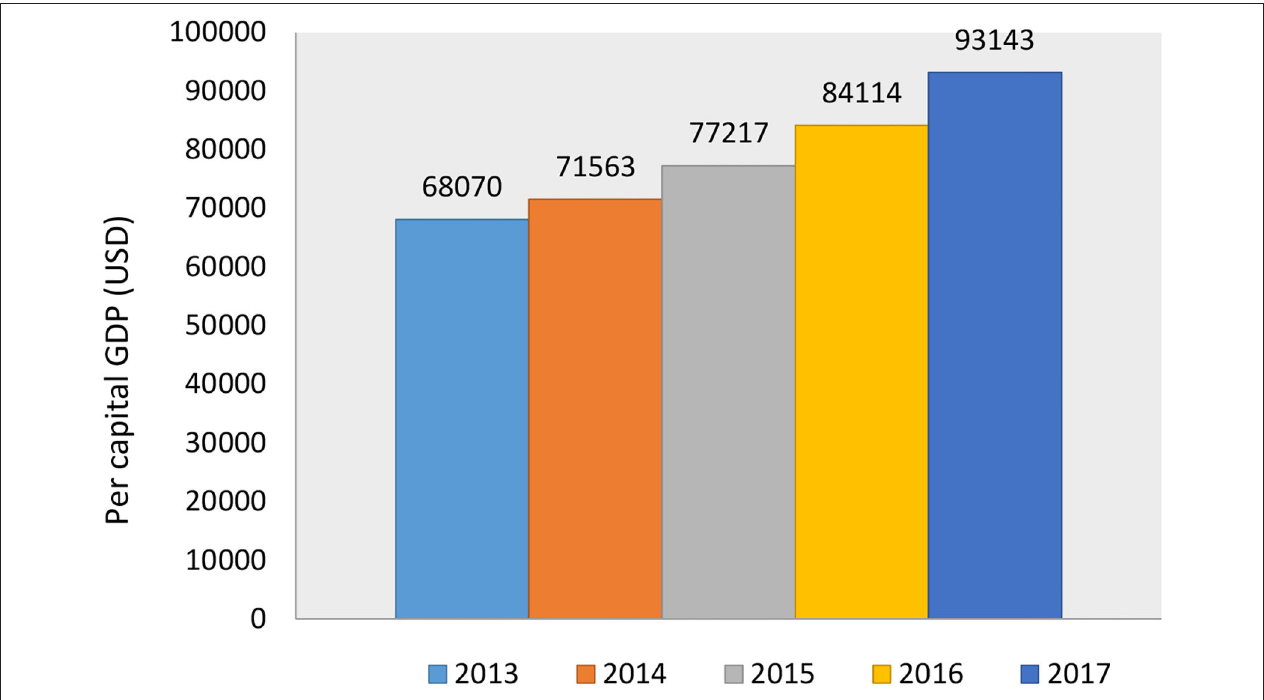
FIGURE 1 | Z City’s per capital GDP trends from 2013 to 2017.